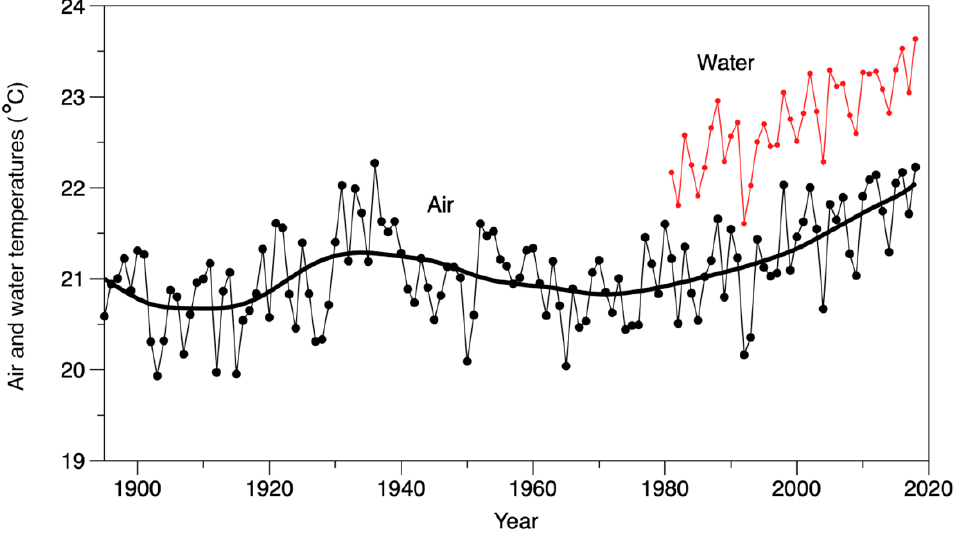
Figure 7. National average summer air temperatures for the conterminous United States for the period 1895 through 2018 with a non-parametric (Locally Weighted Scatterplot Smoothing (LOWESS)) line. The upper red line represents the average summer water temperatures.